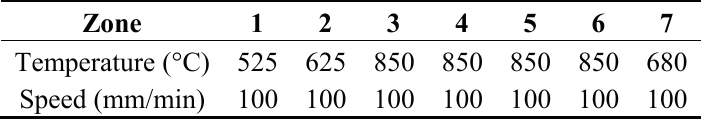
Table 3. Low-temperature sintering parameters.